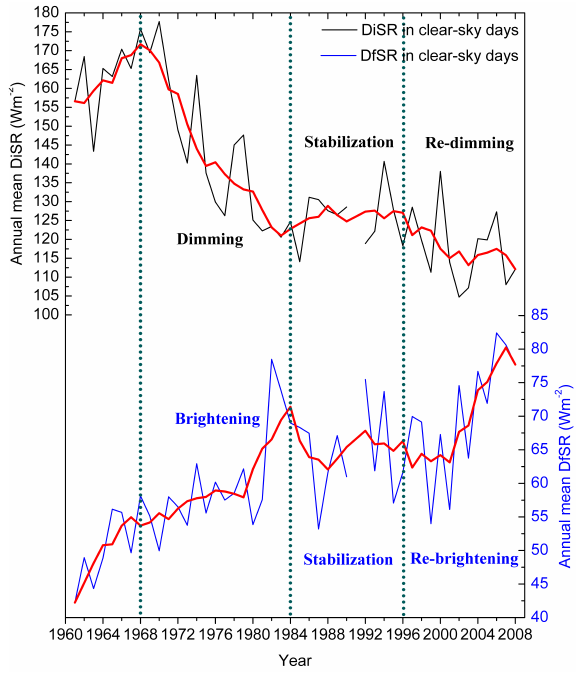
Fig. 1. Annual mean of direct surface solar radiation (DiSR, shown in black line) and diffuse surface solar radiation (DfSR, shown in blue line) observed on clear-sky days during the period of 1961– 2008 in Shanghai. Five year moving averages are also shown in red lines. Units are Wm − 2 .